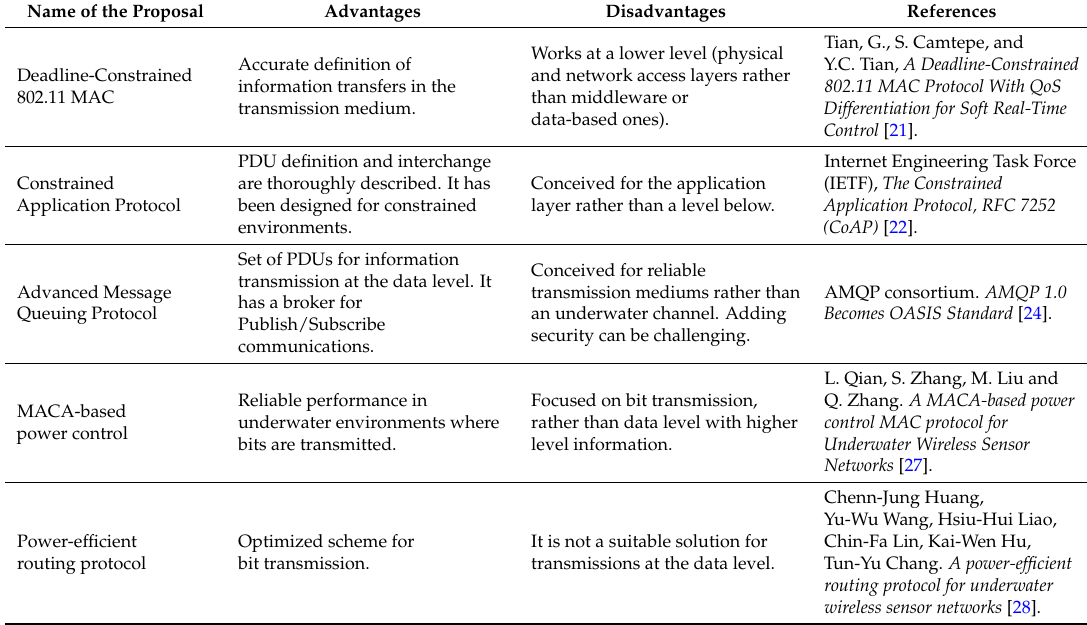
Table 1. Summarized advantages and disadvantages of the studied